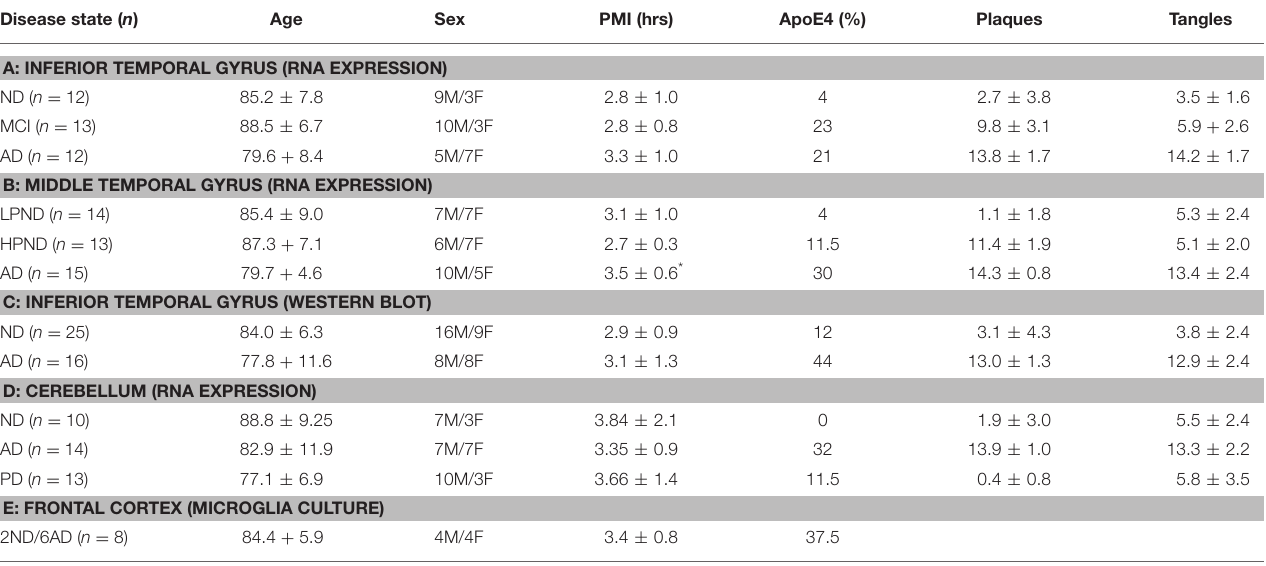
TABLE 1 | Demographic details of human brain cases used. Disease state ( n ) Age Sex PMI (hrs) ApoE4 (%) Plaques Tangles